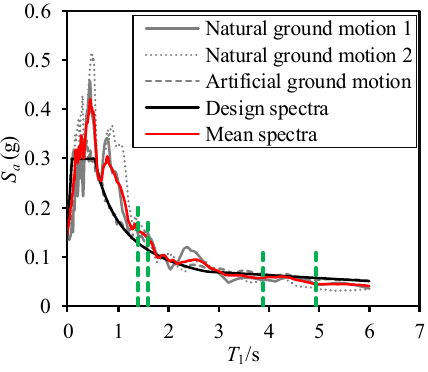
Figure 3. Response spectra of design ground motions.